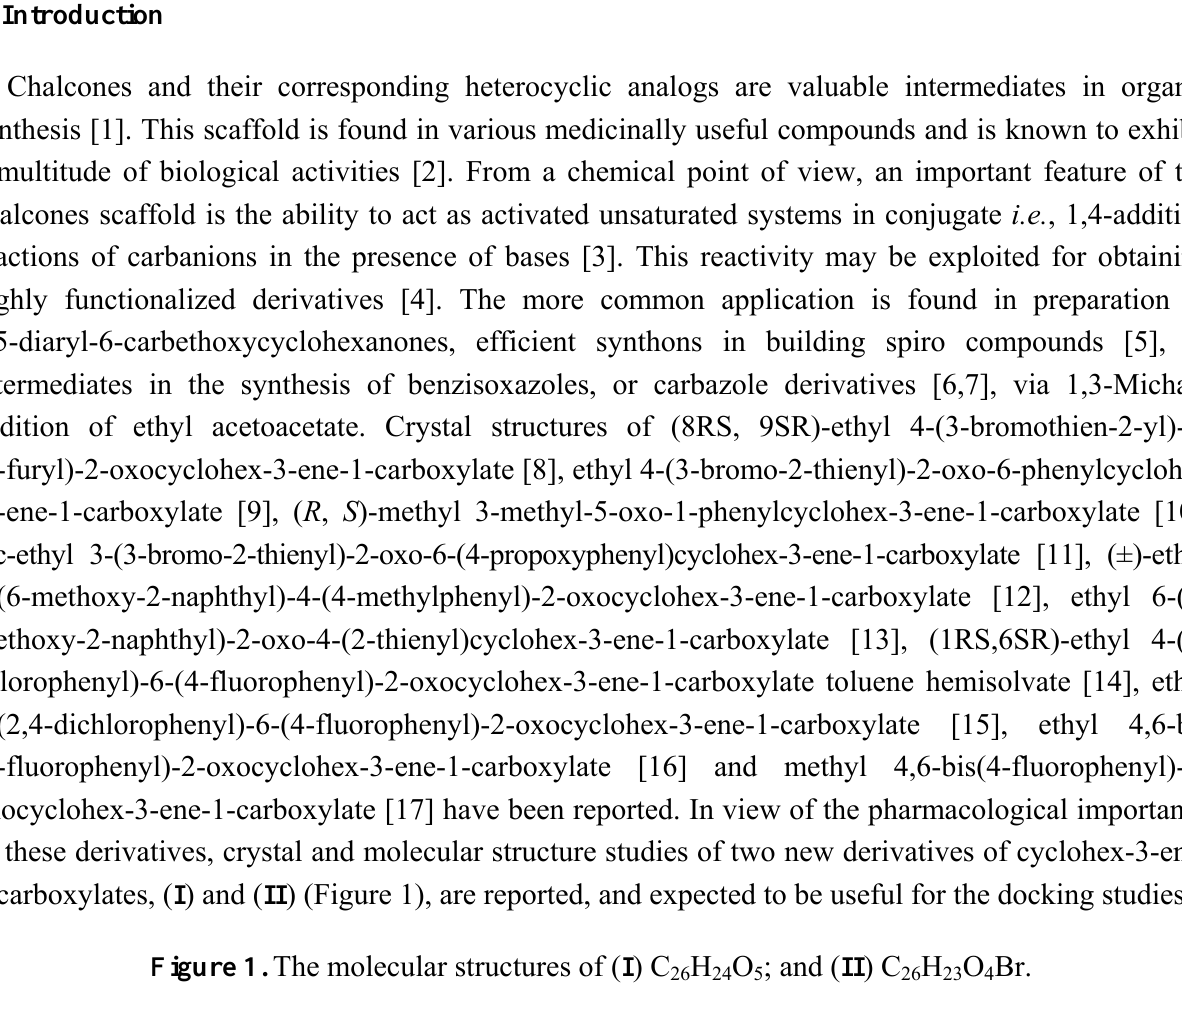
Figure 1. The molecular structures of ( I ) C